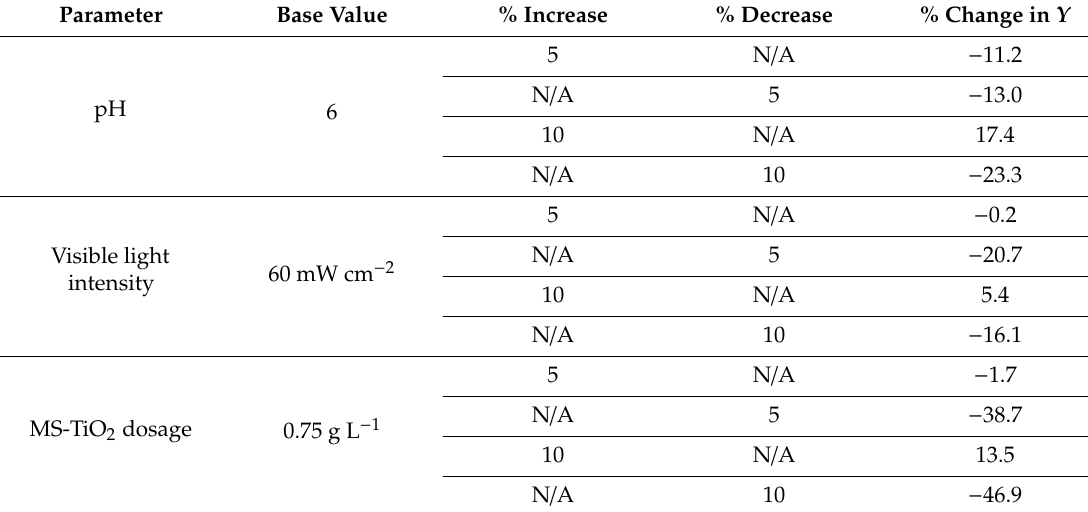
Table 4. Result of sensitivity study.